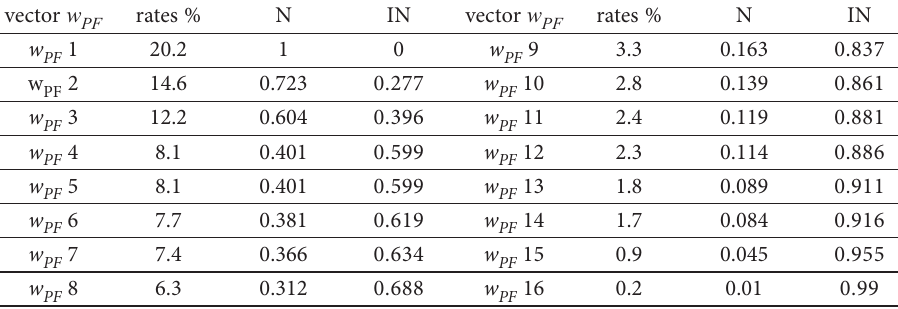
Table 7. Colombia’s PF for doing business rates vector w PF rates % N IN vector w PF rates % N IN w 1 PF